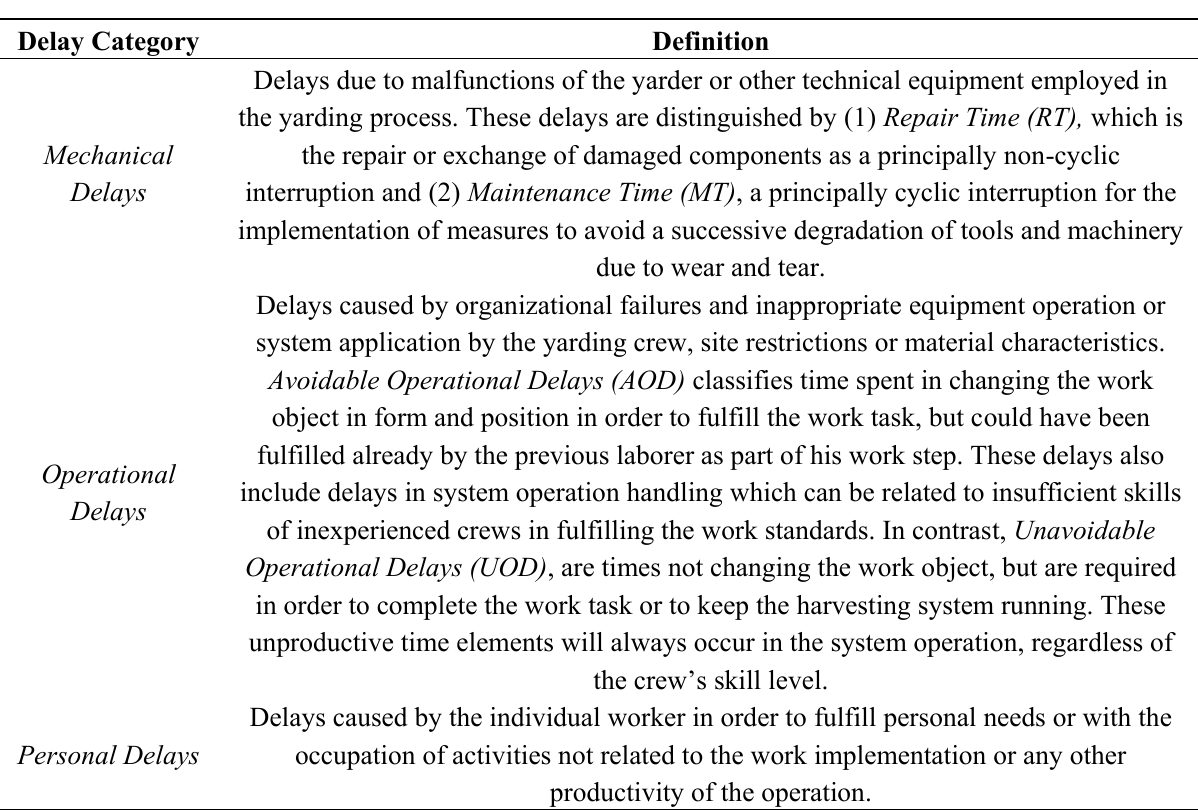
Table 4. Definition of IUFRO (International Union of Forest Research Organizations) delay time categories [26],